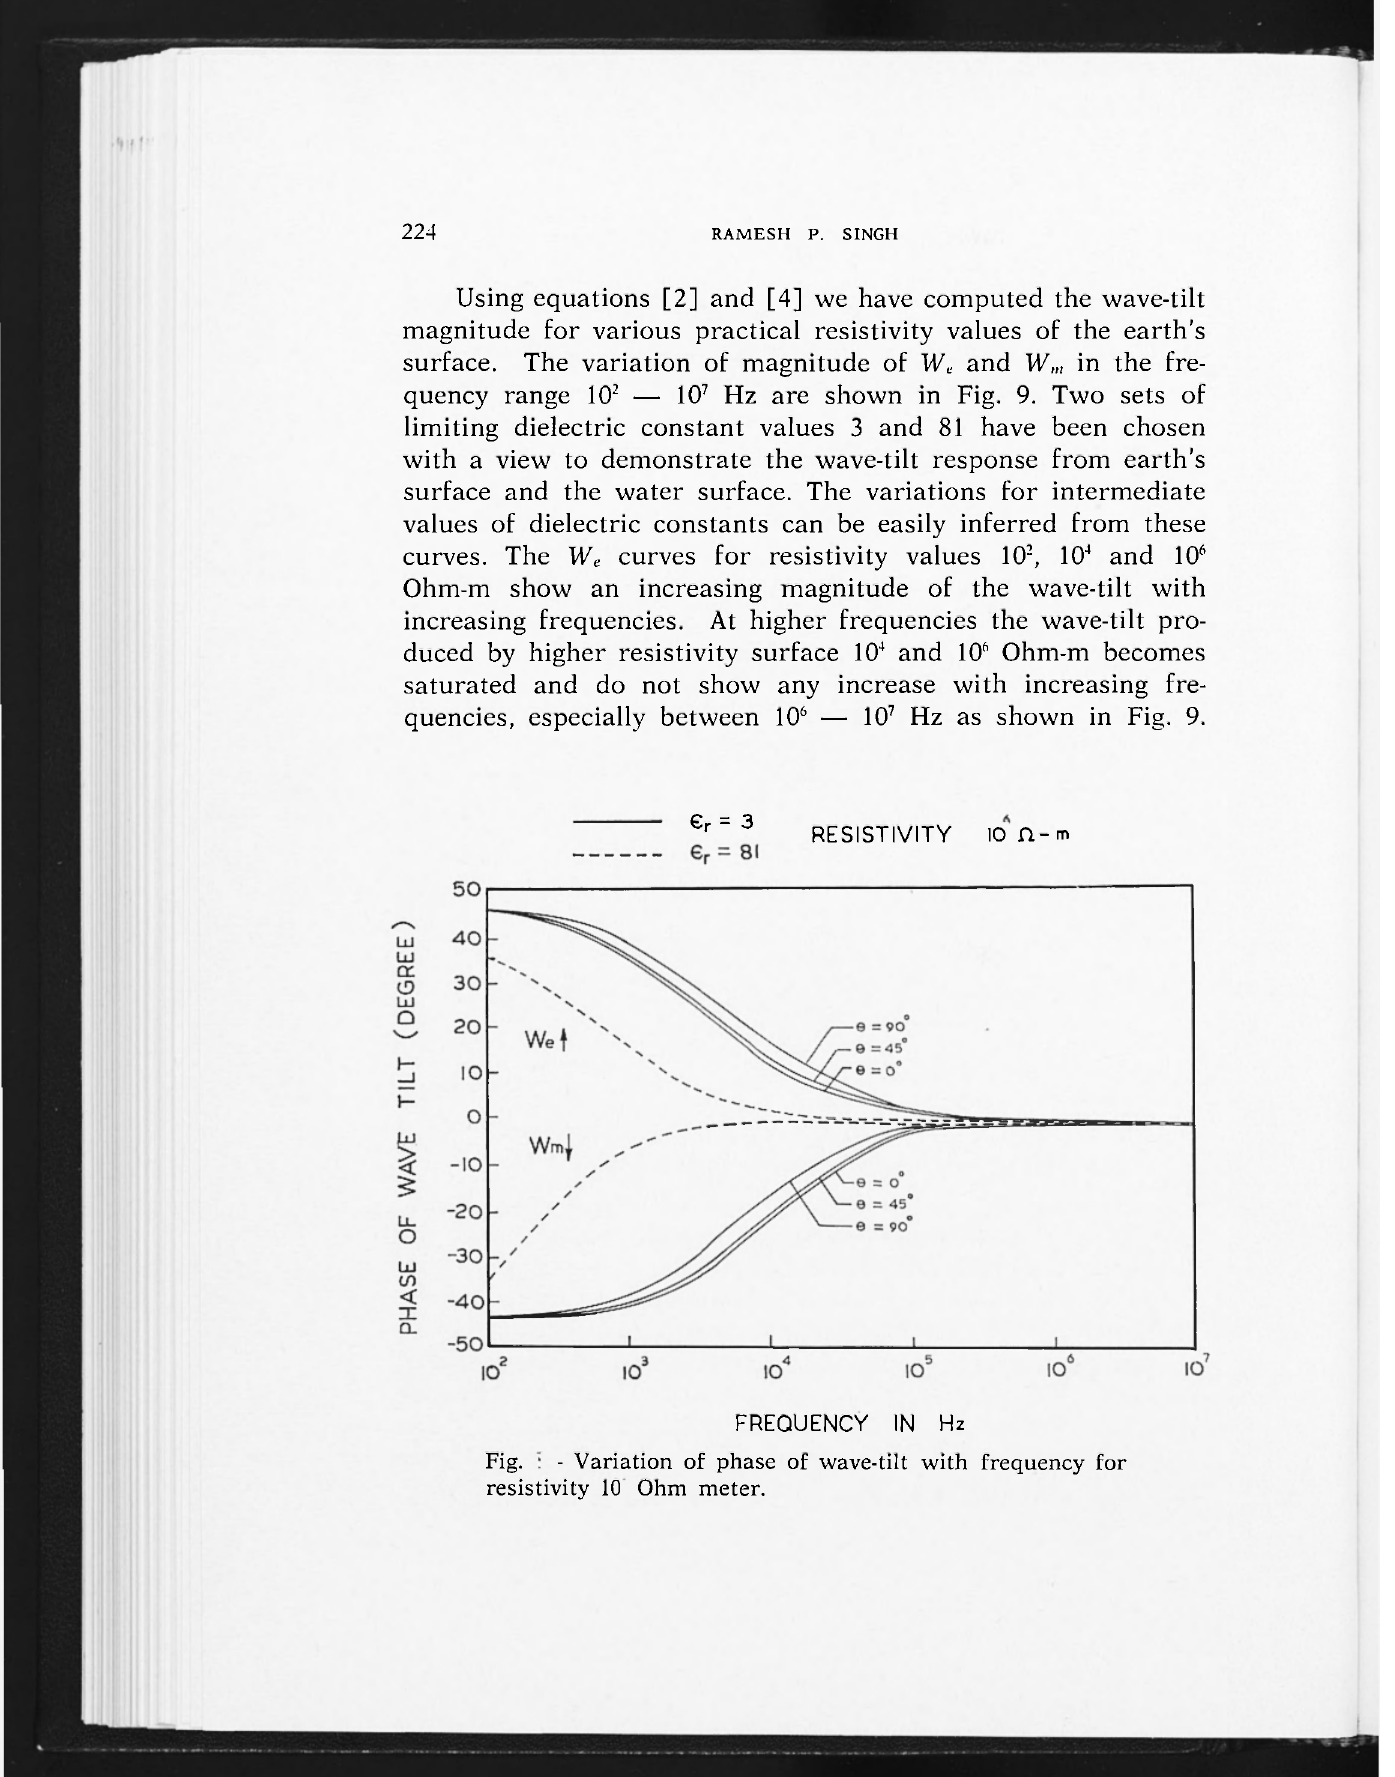
Fig. 4 - Variation of phase of wave-tilt with frequency for resistivity 10 2 Ohm